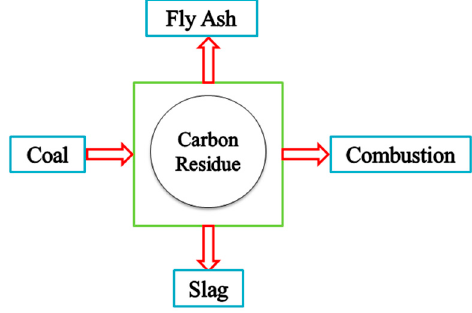
Figure 22. The evolution of char particles in coal.